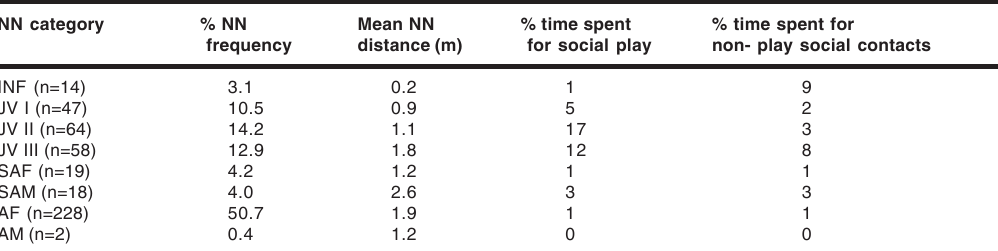
Table 2. Percentage NN frequency, mean NND, percentage time spent for social play and non play social contacts regarding each NN category. (n = number of individuals). (Symbols as in